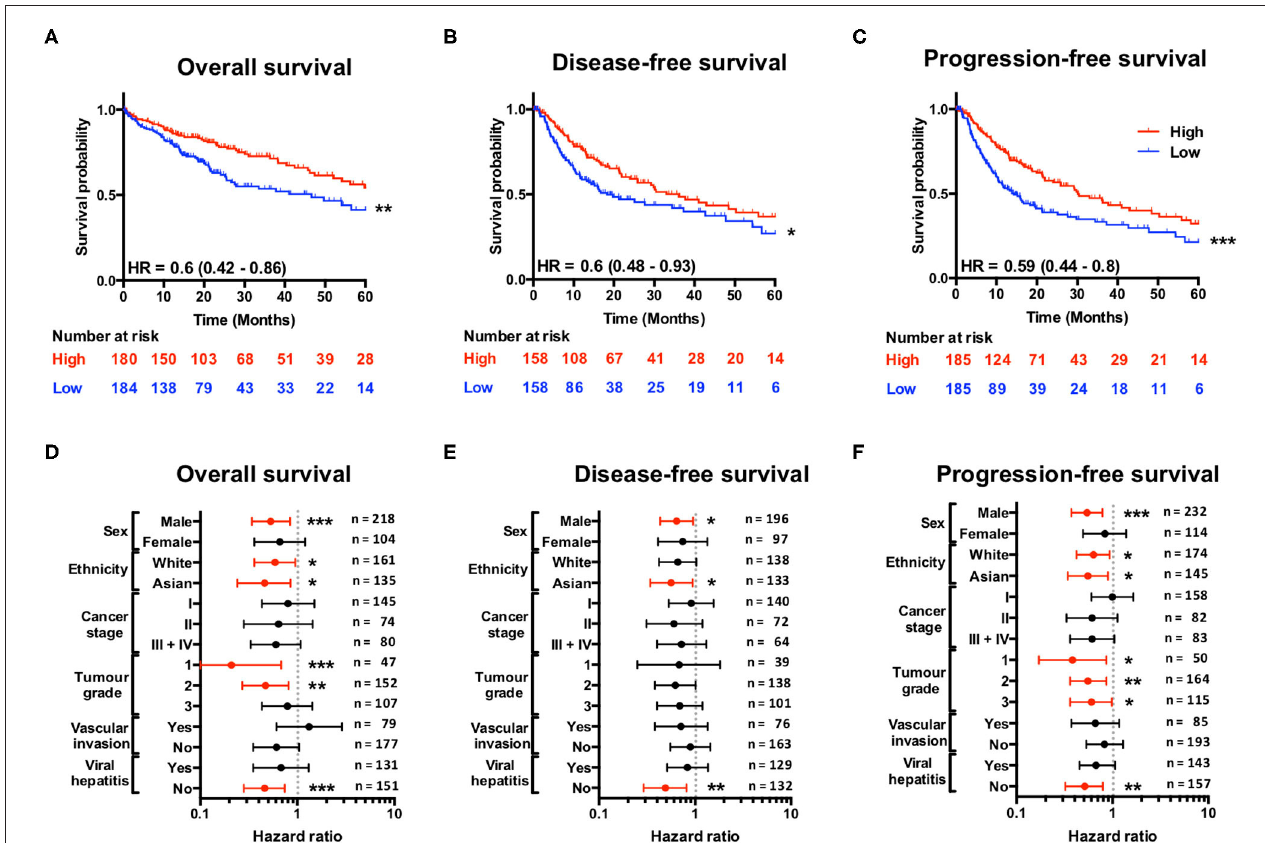
FIGURE 3 | SCARF1 expression is predictive of survival in HCC. (A) Overall survival, (B) Disease-free survival, and (C) Progression-free survival of HCC patients separated into two groups (“High” and “Low” expression) via the median expression of SCARF1. *, ** and *** indicate statistical significance where p ≤ 0.05, p ≤ 0.01, or p ≤ 0.005, respectively. HR = hazard ratio. Forest plots of (D) Overall survival, (E) Disease-free survival, and (F) Progression-free survival in relation to various clinicopathological features of HCC patients. Data is displayed as hazard ratio with 95% confidence intervals. (D–F) Red plots highlight clinicopathological parameters in which statistical significance was achieved. *, ** and *** indicate statistical significance where p ≤ 0.05, p ≤ 0.01 or p ≤ 0.005, respectively. Data in this Figure was generated with use of KM Plotter